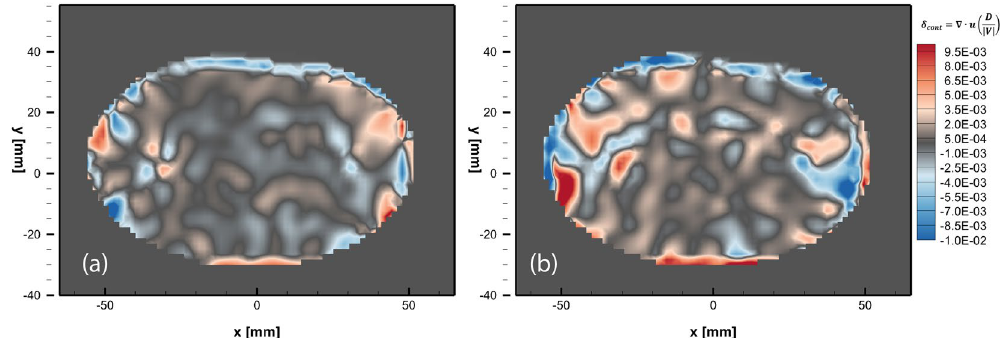
Figure 16. Contours of normalized residuals from the continuity equation, ∇ · u , for ( a ) first time-step (G-R) and ( b ) second time-step (R-B), taken at the plane Z = 0